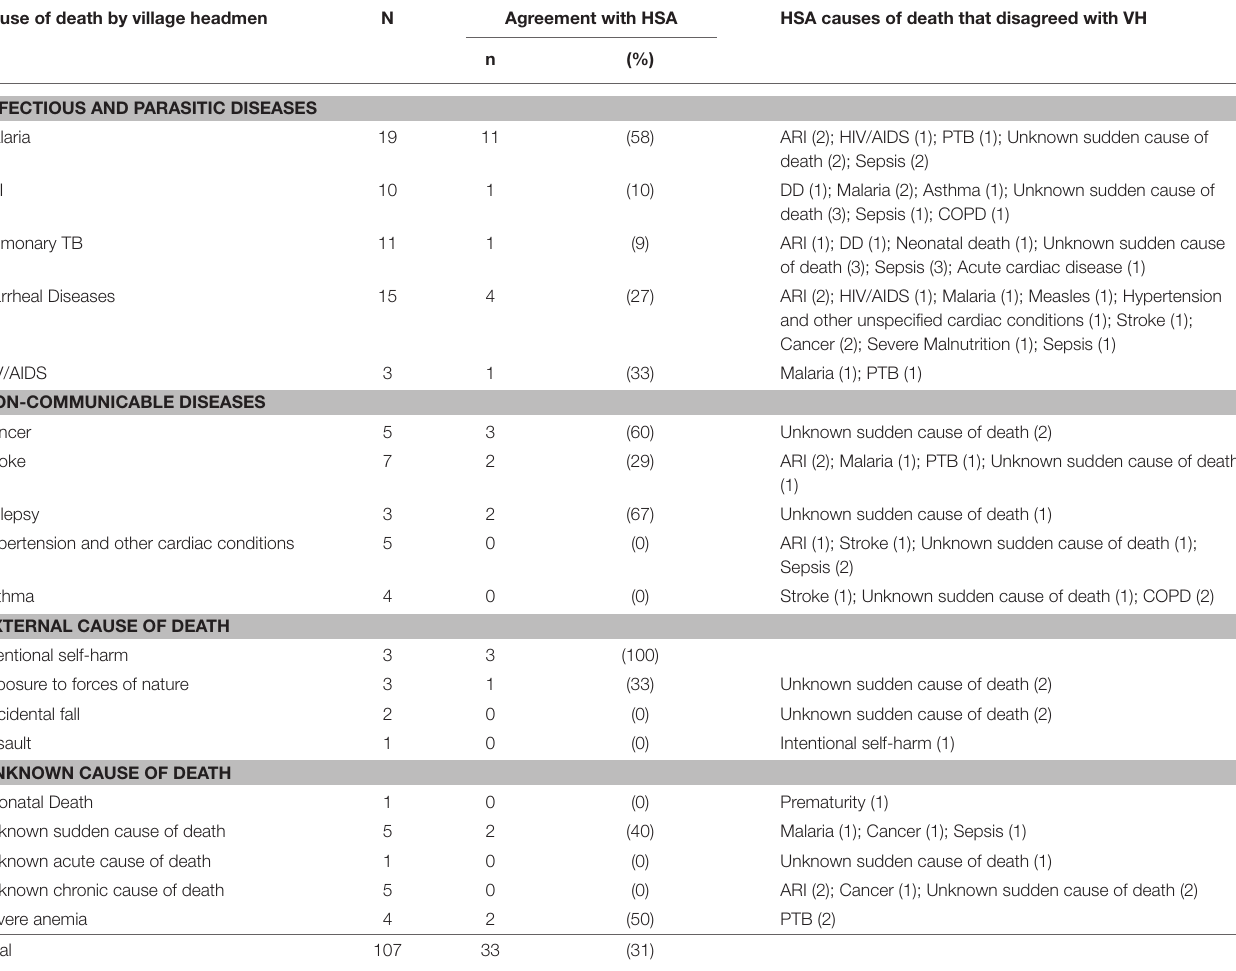
TABLE 5 | Comparisons of specific causes of death between Village Headman and HSA: levels of agreement and specified causes of disagreement, Traditional Authority Mtema, Malawi, April 2016–September 2017. Cause of death by village